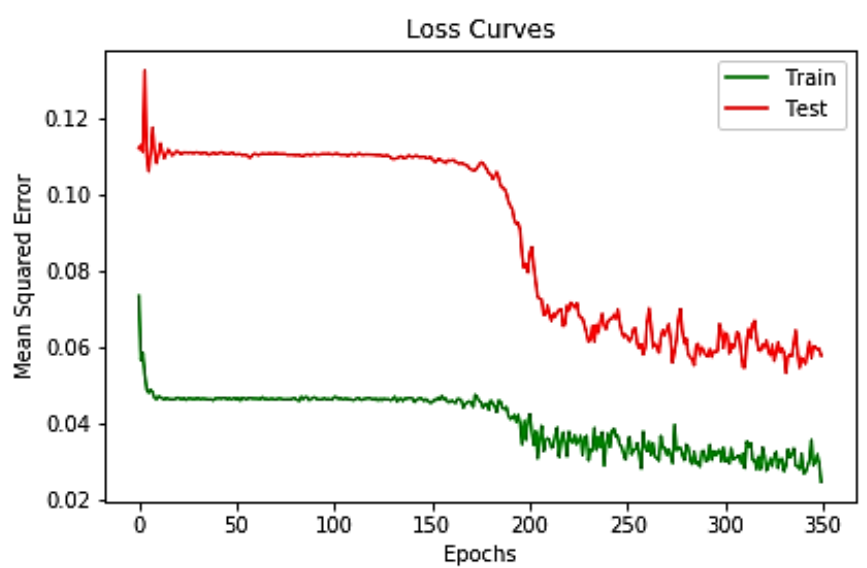
Figure 3. Learning curves of mean squared error as a function of the number of epochs. The red solid red curve represents the average 20-fold cross-validated loss scores on the validation fold, and the green solid curve corresponds to the 20-fold cross-validated loss score on the training data.